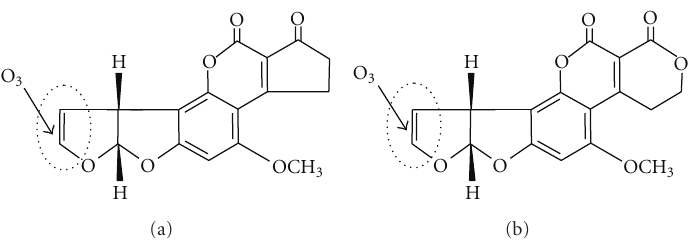
Figure 1: Chemical structures of the two more toxic aflatoxins, (a) AFB 1 and (b) AFG 1 , with the sites of ozone oxidative attack (8,9 double bond of final furan rings in both